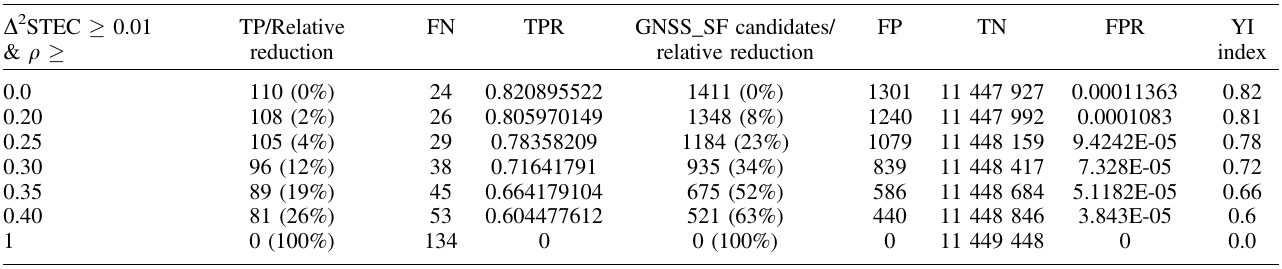
Table 4. Contingency table for several threshold values of correlation when the fi x condition D 2 STEC (cid:8) 0.01 is imposed